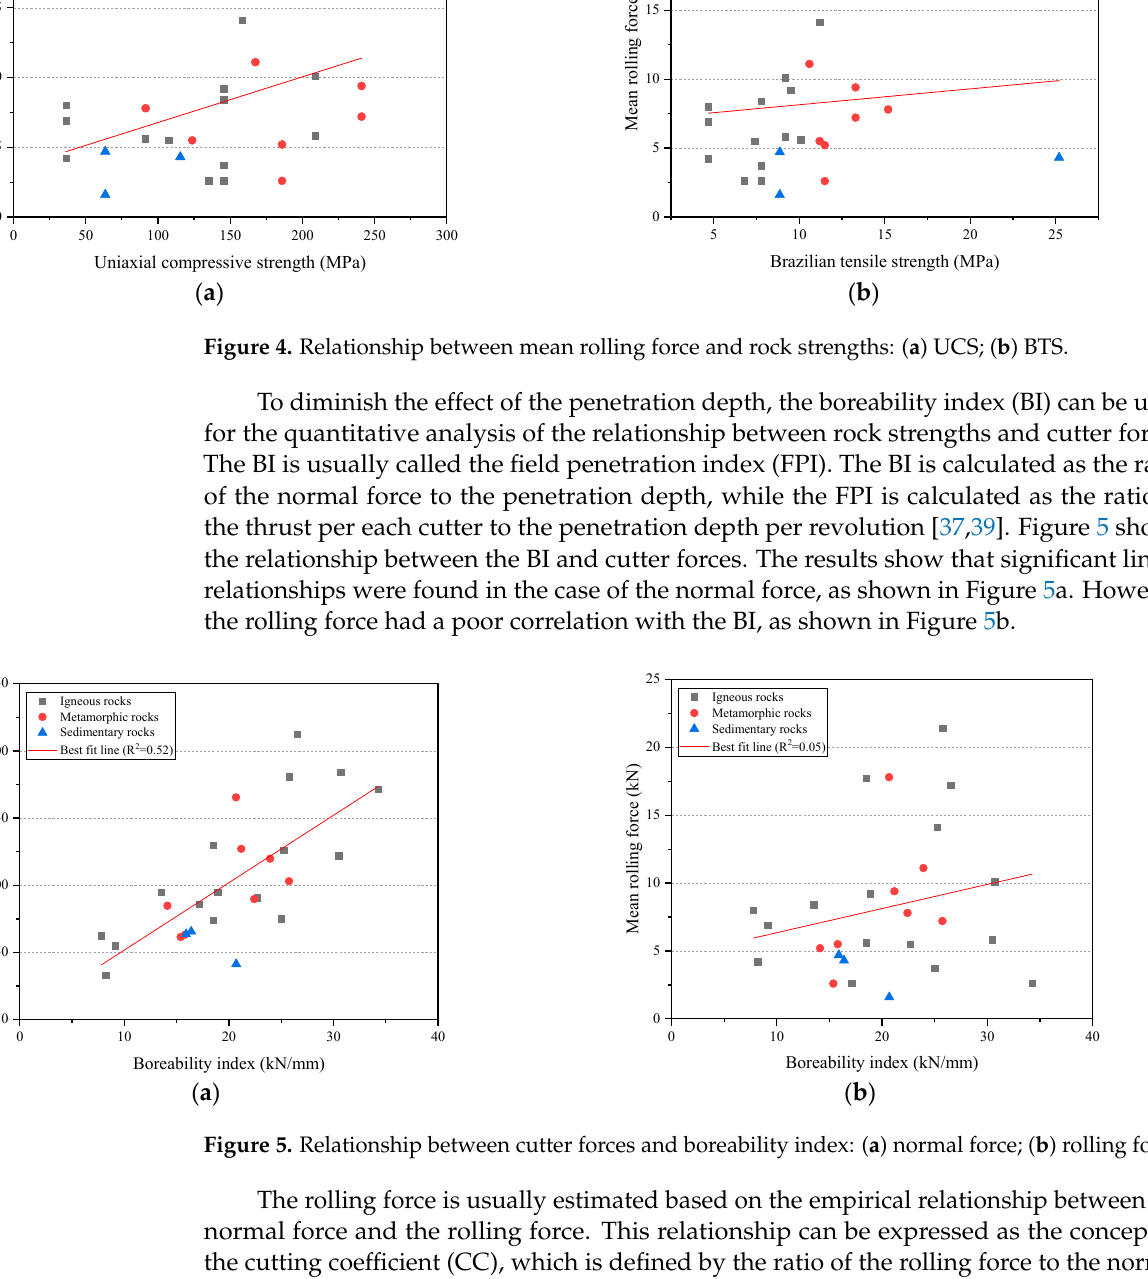
Figure 3. Relationship between mean normal force and rock strengths: ( a ) UCS; ( b ) BTS.